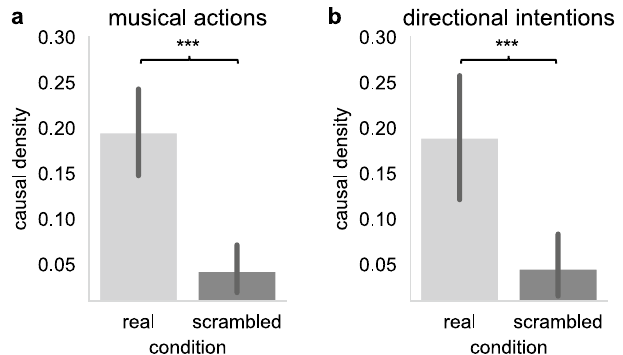
Figure 3. Causal density between pairs of musicians for musical actions and directional intentions. Causal density (Granger causality averaged across the two musicians) between real and time scrambled pairs of musicians’ musical actions (( A ), left) and directional intentions (( B ), right). Error bars show 95% confidence intervals, and black asterisks show the pairwise t-test comparing real vs. scrambled data with *** corresponding to p <